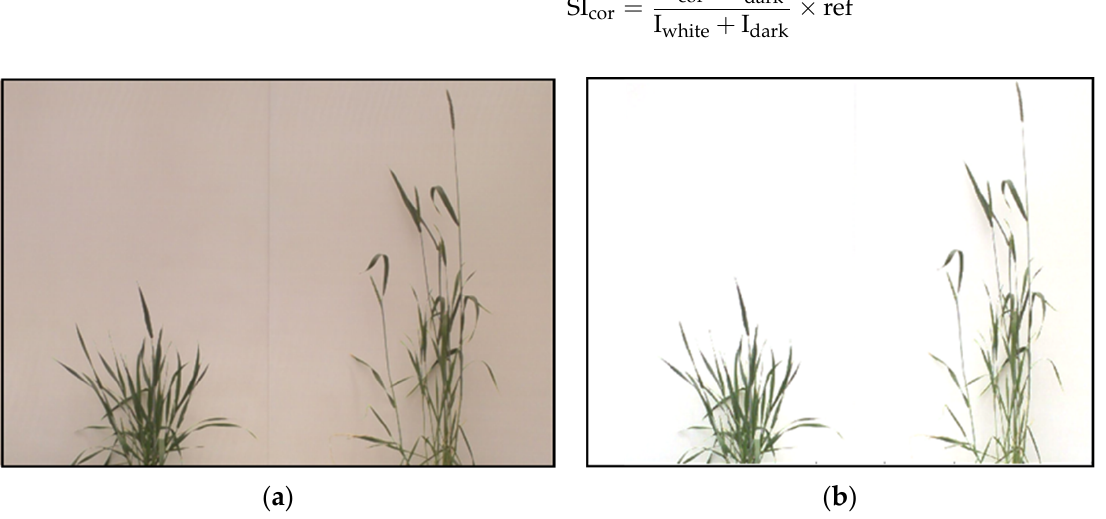
Figure 9. Output of RGB images after ( a ) gradient correction and ( b ) illumination correction.